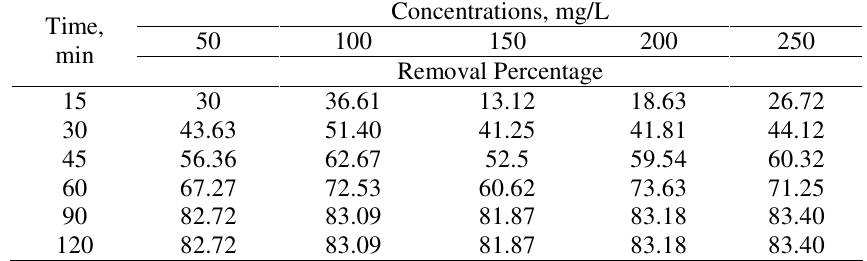
Table 2. Effect of initial dyes concentration on dye removal (absorption dosage 0.5 g 100 m/L